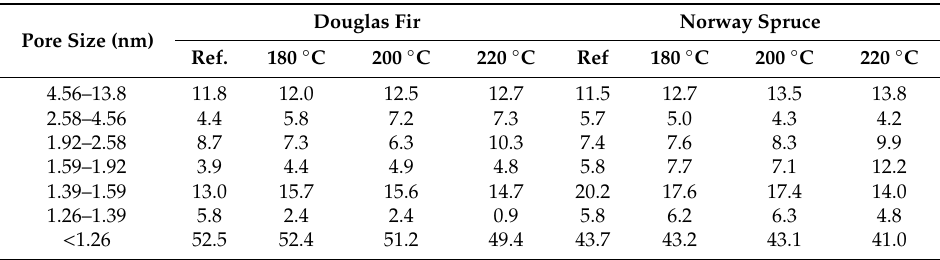
Table 6. The pore size distribution (PSD) of water saturated cell walls (unit: %). Douglas Pore Size (nm)